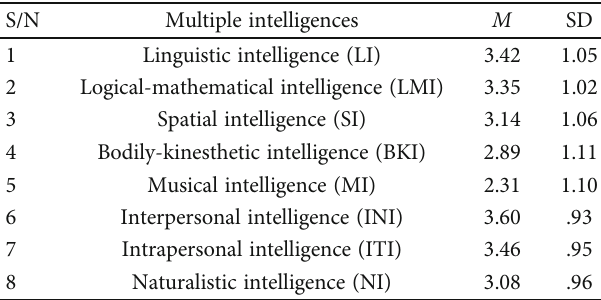
Table 2: Domains of multiple